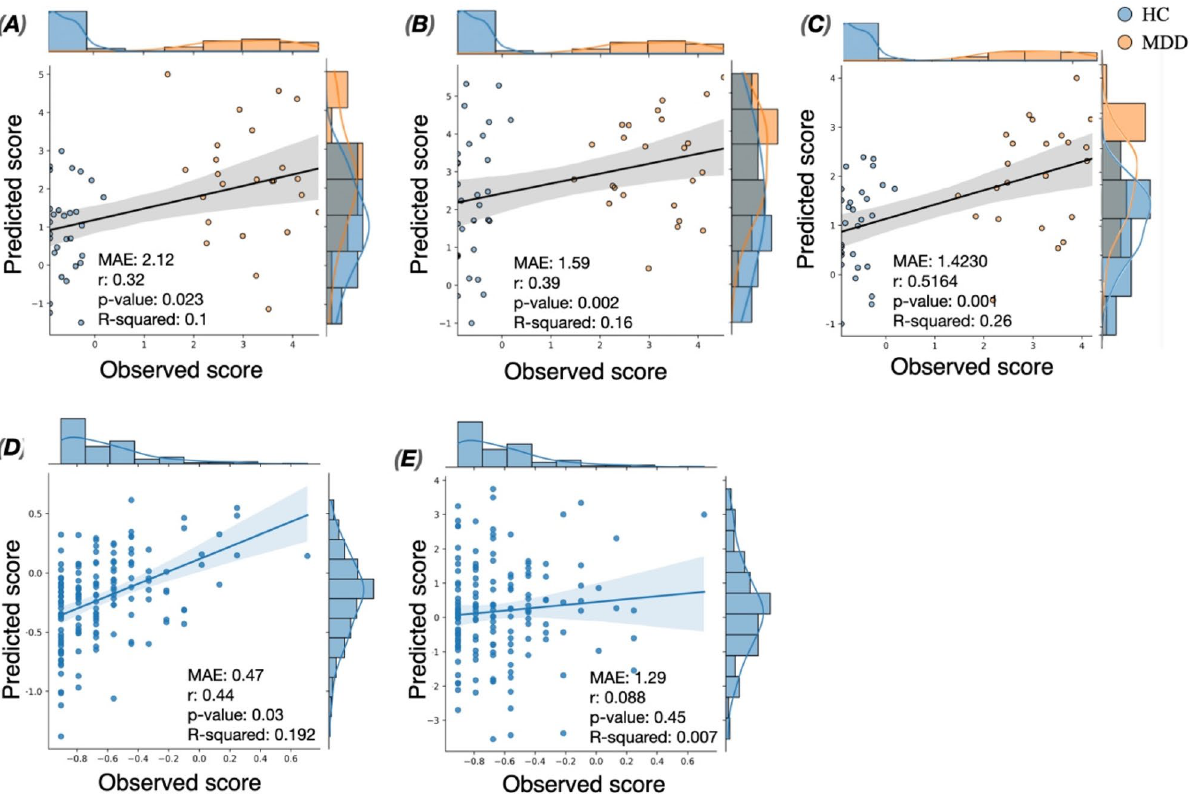
Figure 4. ( A ) Correlation between the predicted and observed Hamilton scaling score of the second dataset using high-depressive network, ( B ) the prediction results of the second dataset using low-depressive network, ( C ) the prediction results of the second dataset using both high and low depressive network. ( D ) The prediction results of the third dataset using high depressive network. ( E ) The prediction results of the third dataset using low depressive